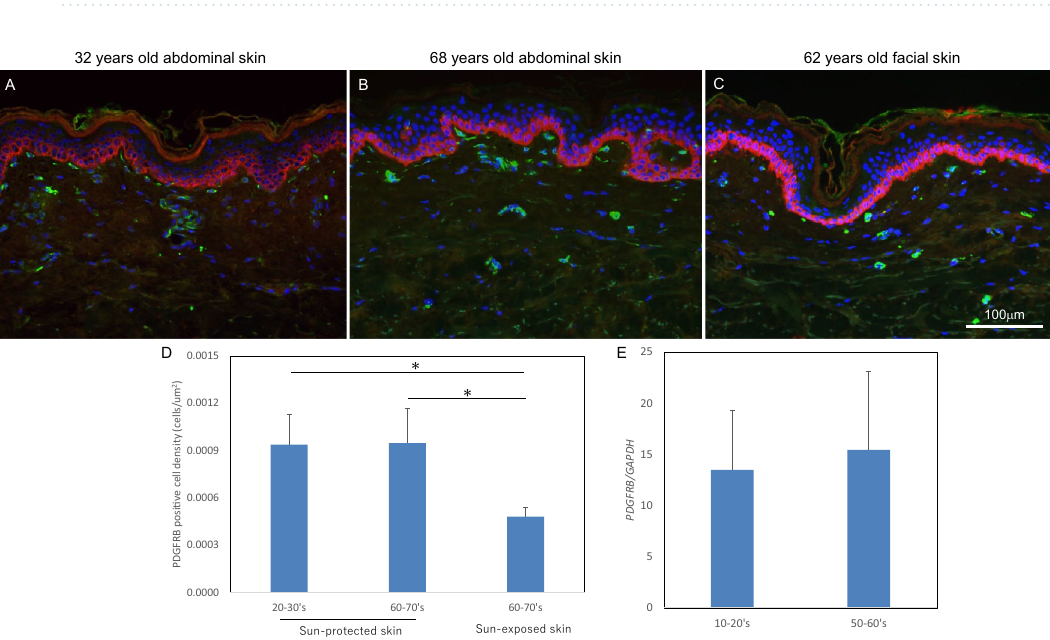
Figure 7. Localization of PDGFR-beta positive cells in human skin. Immunostaining of PDGFRβ in young sun-protected skin ( A ), older sun-protected skin ( B ) and older sun-exposed skin ( C ). PDGFRβ-positive cell density was analyzed by using WINROOF 2015 ( D ). Bars: 100 μm. Data are the means ± SD of six images from each of six donors. mRNA expression level of PDGFRB in cultured fibroblasts was analyzed by qPCR ( E ). Data are expressed as mean ± SD of six independent experiments on samples from six